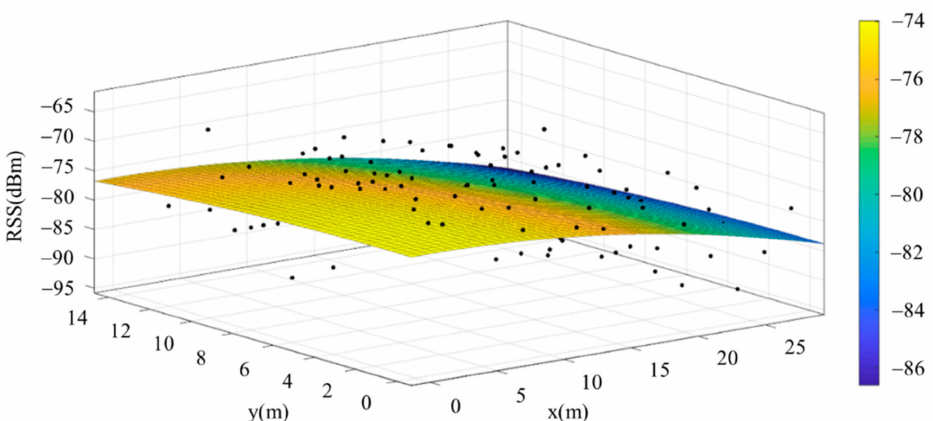
Figure 17. Fitting Model for Same Base Station Using Data Collected Facing West.